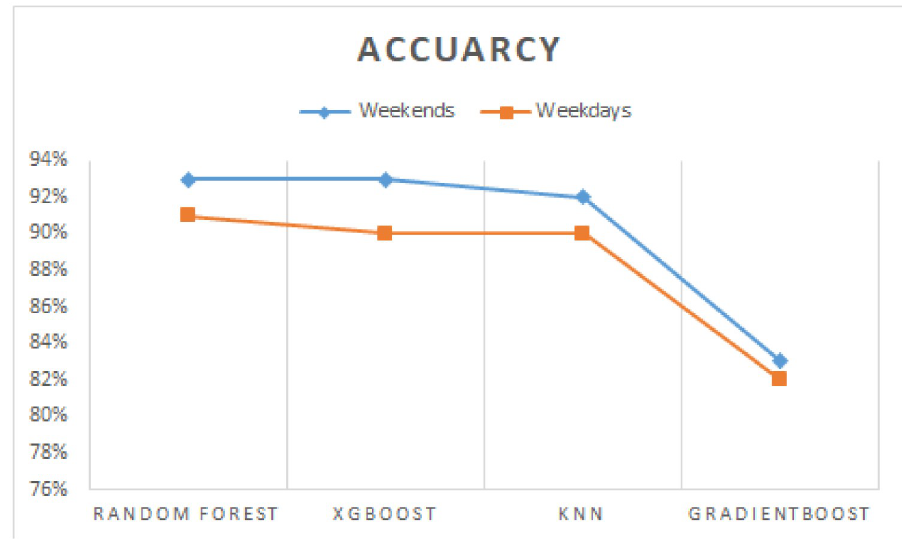
Fig 10. Cross-validated scores of multiple algorithms with weekends and